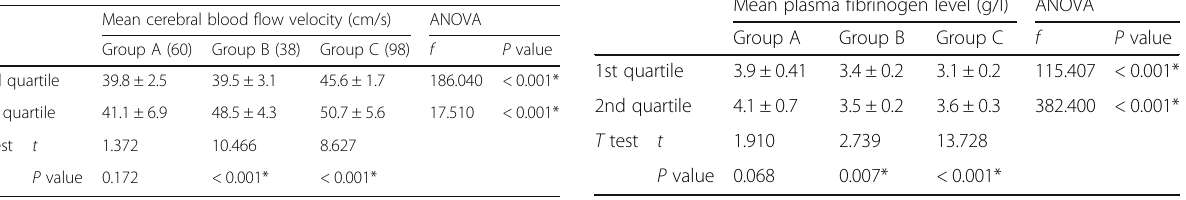
Table 3 Mean cerebral blood flow velocity level in stroke patients and control group